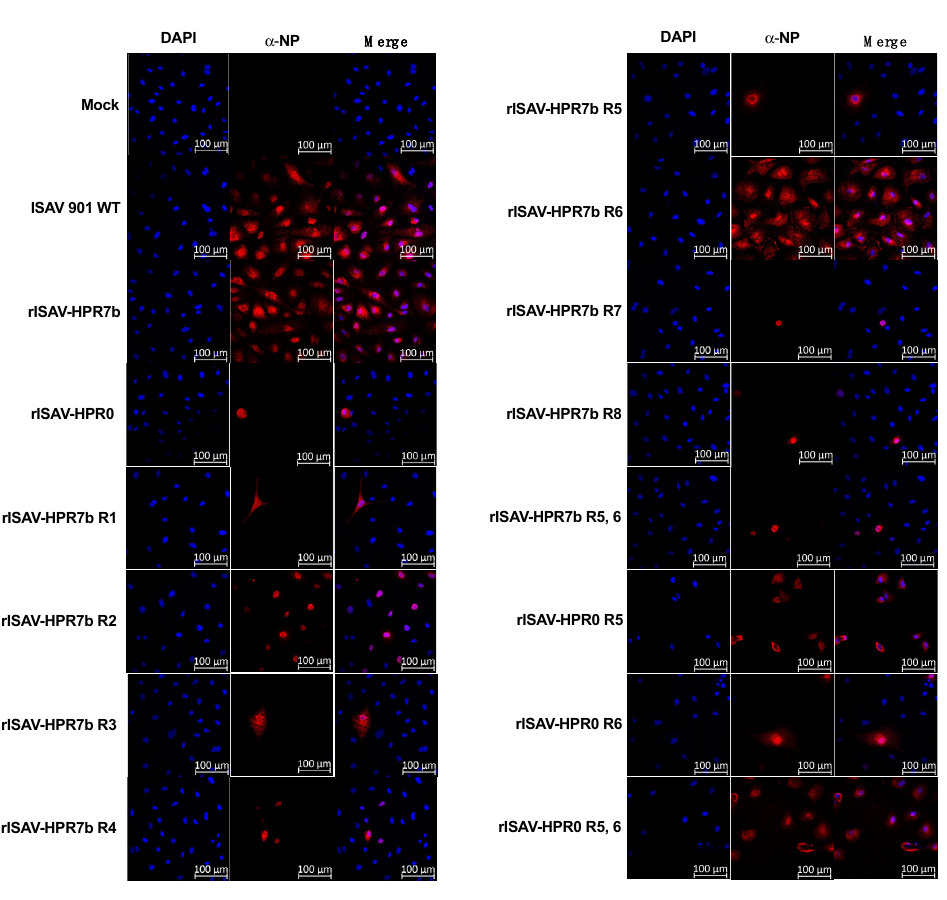
Figure 3. rISAV-NP protein detection by immunofluorescence in infected ASK cells. ASK cells were infected with each rISAV, incubated for five days, and analyzed by immunofluorescence for NP detection using a monoclonal anti-NP primary antibody and an anti-mouse Alexa Fluor 594-conjugated secondary antibody (red). Cellular DNA in the nucleus was stained with DAPI (blue). Non-infected cells and ISAV 901-infected cells are included as controls of NP expression. Scale Barr: 100 µM.